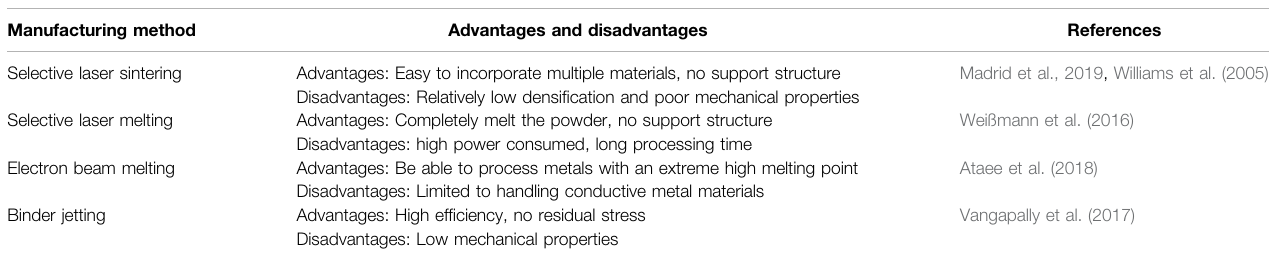
TABLE 6 | The commonly used manufacturing methods for producing the